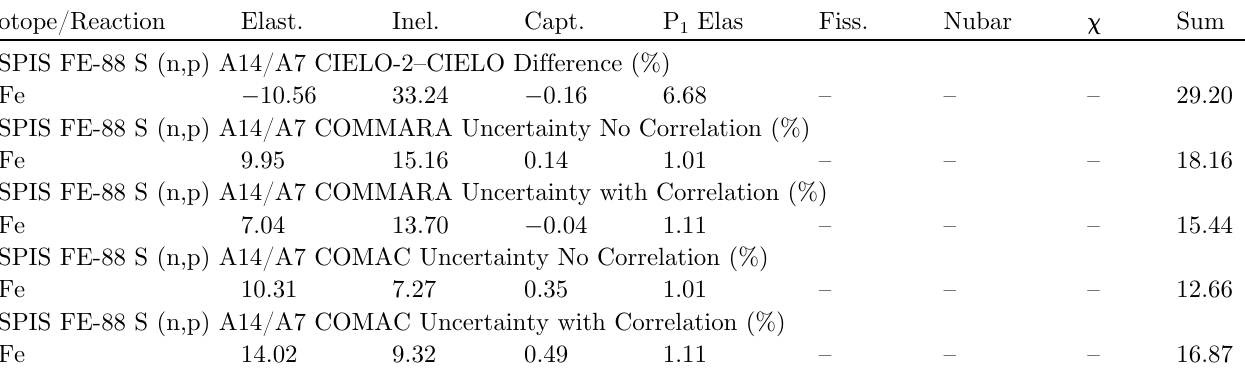
Table 7. (C-E)/E of CIELO and CIELO-2 56 Fe and consistency with uncertainty of COMMARA 2.0 and COMACV1: ASPIS FE-88.